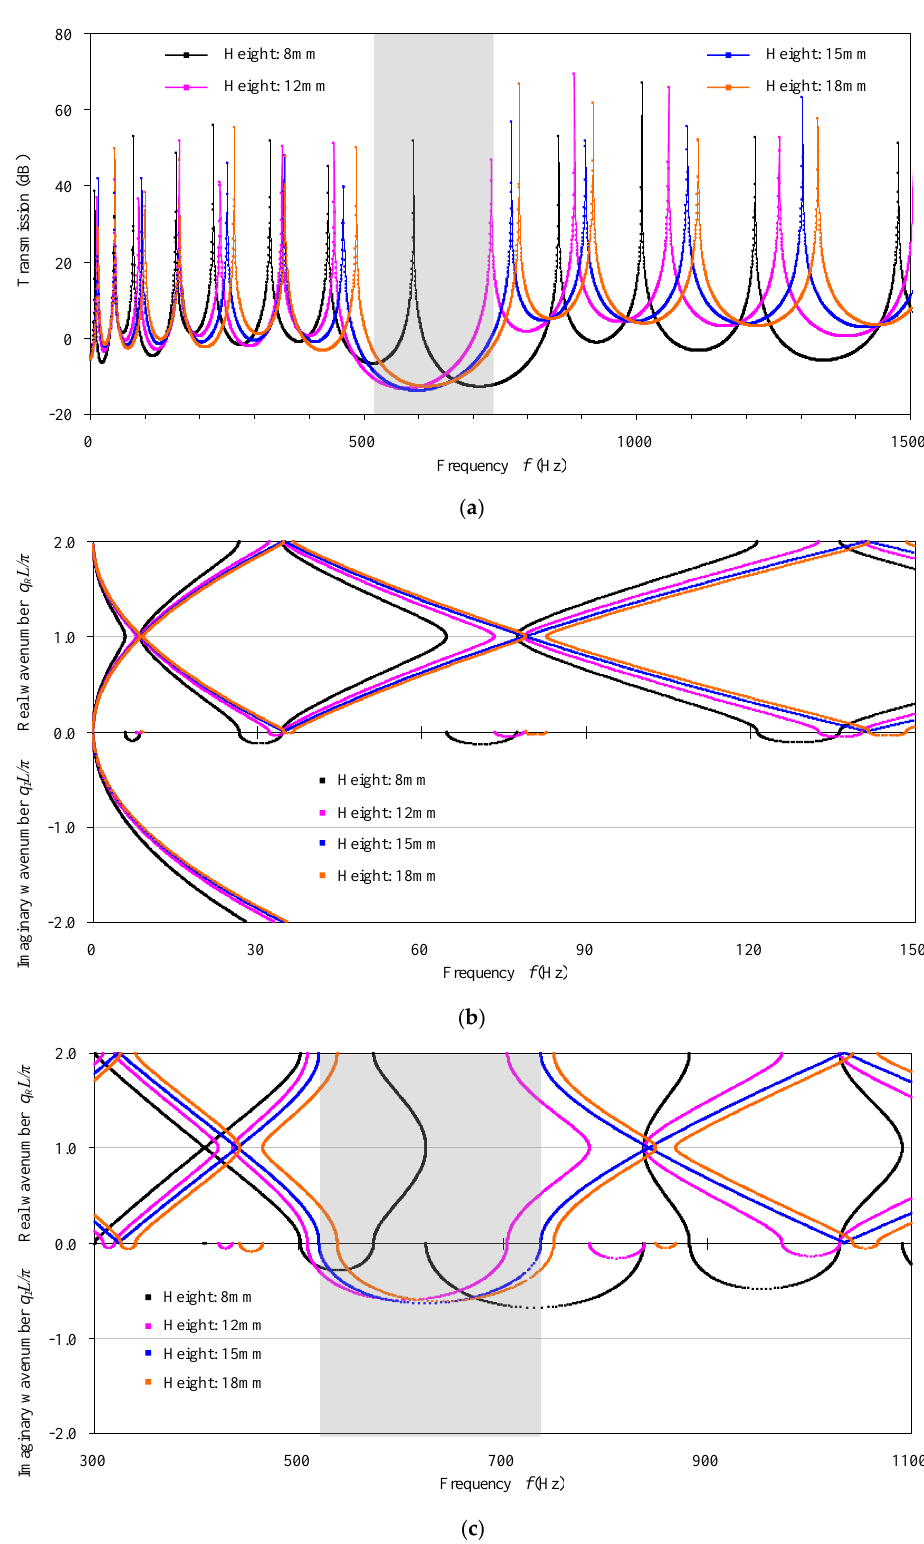
Figure 10. The transmission spectra and the band structures of the four phononic crystal beams with the PMMA beam in the fifth unit cell having cross-sectional height 8 mm, 12 mm, 15 mm, and 18 mm, respectively: ( a ) Transmission spectra within f ≤ 1500 Hz; ( b ) Phase and attenuation constant spectra within f ≤ 150 Hz; ( c ) Phase and attenuation constant spectra within 300 Hz ≤ f ≤ 1100